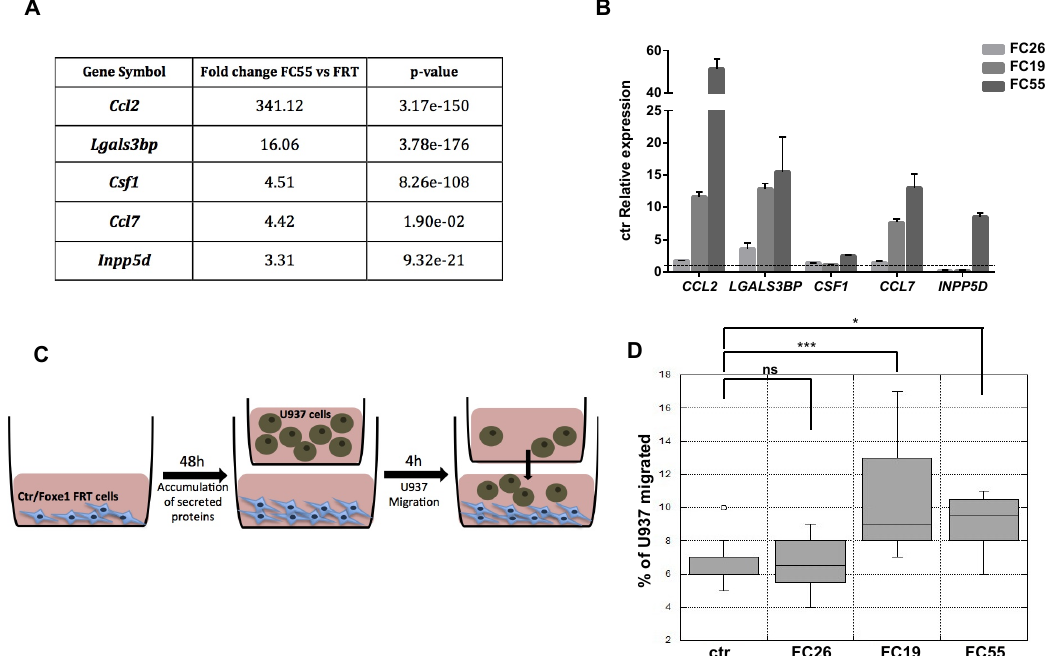
Figure 3. FOXE1 modulates macrophage-related genes and their migration in vitro. ( A ) Macrophage-related genes from RNA-seq analysis of FOXE1-expressing FRT. ( B ) Quantitative RT-PCR analysis of genes in A in FOXE1 clones with low (FC26), moderate (FC19) and high (FC55) FOXE1 expression. The data are shown as ctr-relative expression (2 - ∆∆ Ct ). Actin was used to normalise. The starting value of the control, set to 1, is indicated by the dotted line. ( C ) Ctr cells and FOXE1 clones were seeded in transwell low chamber and U937 cells were added in the upper chamber after 48 h. ( D ) The percentage of migrating U937 cells was evaluated after 4 h. One-way ANOVA test was performed on data, and p -values are reported for each clone relative to ctr. * p < 0.05, *** p < 0.001, ns: not significant.